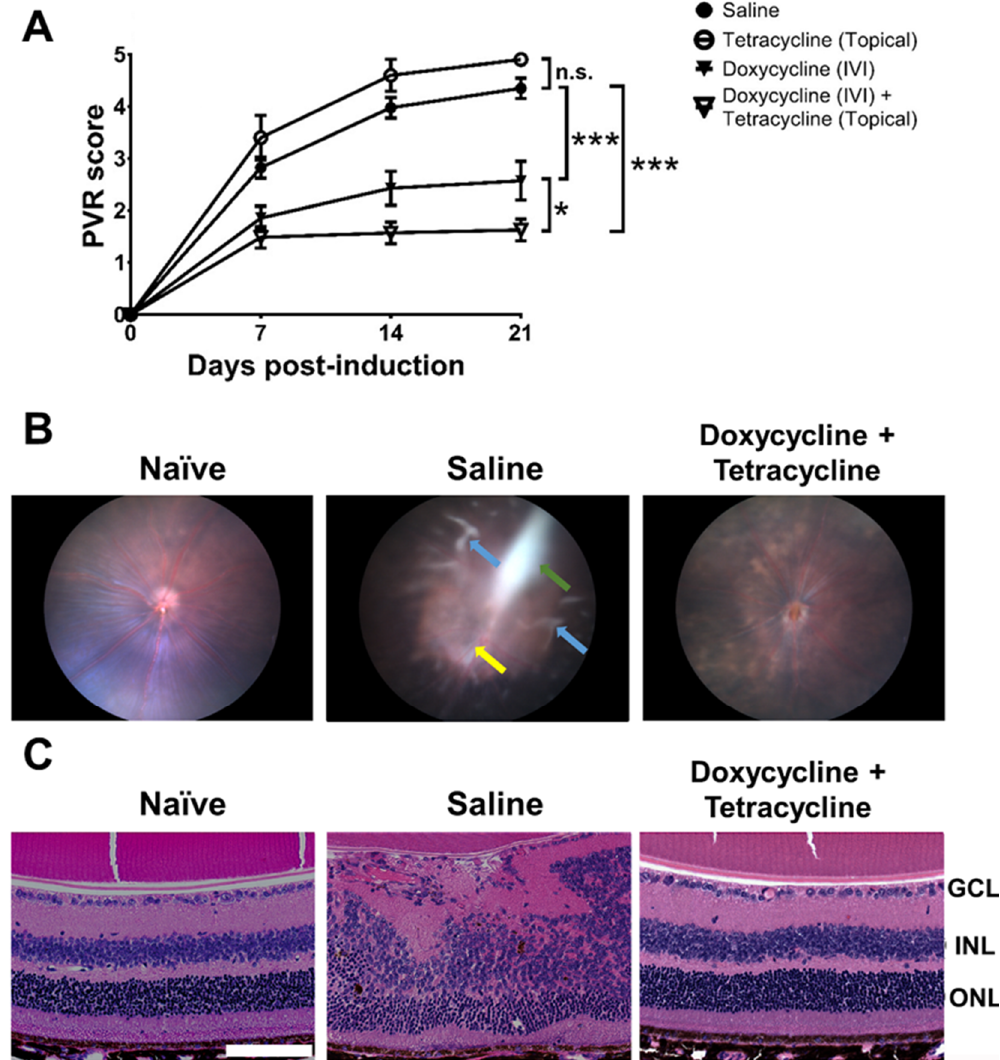
Figure 3. Doxycycline and tetracycline treatment reduces PVR in mice. ( A ) After PVR induction and treatment with saline and doxycycline by IVI injection or tetracycline topically, mice were monitored for disease scores in the fundus using a slit lamp on the indicated days post-induction. The data represent means ± SEM (error bars) of ≥10 mice per data point. Note: *, p < 0.05 and ***, p < 0.001 via the one-way ANOVA followed by the Holm–Sidak test on day 21 post-induction. Note: n.s.: not significant. ( B ) The representative fundus images of naïve mice or mice with PVR induction and treated with saline or doxycycline and tetracycline with ERM (green arrow), inflammation (yellow arrow), and retinal detachment (blue arrows) are shown. ( C ) The eyes of mice described in ( B ) were harvested 21 days after induction, sectioned, and stained with H&E. GCL: ganglion cell layer; INL: inner nuclear layer; ONL: outer nuclear layer. Scale bar, 100 µ m. Data are representative of at least 2